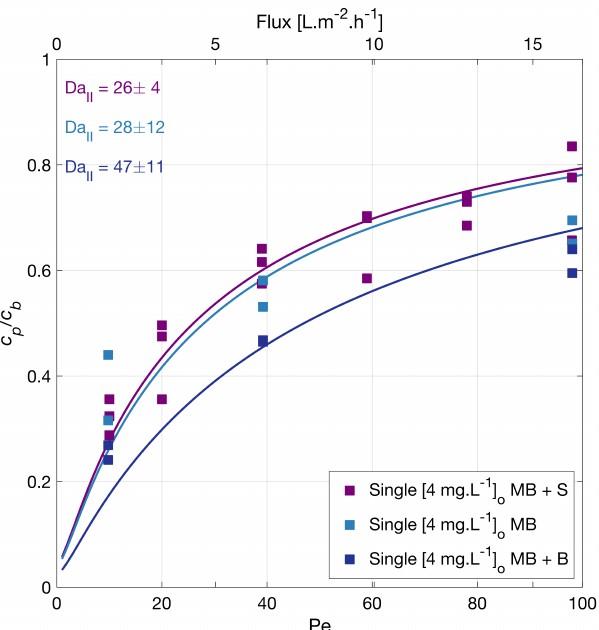
Figure 2. Methylene blue (MB) degradation with different backgrounds vs. filtration rate. Where the MP was alone, or with a background S (142 mg · L − 1 Na 2 SO 4 ) or a background B (23.4 mg · L − 1 NaHCO 3 ). Symbols depict experimental data of the MB independently, and the lines correspond to the mass transport and surface reaction model. The legend shows the feed concentrations [ c b ] o . Conditions: 366 nm radiation, 210 W · m − 2